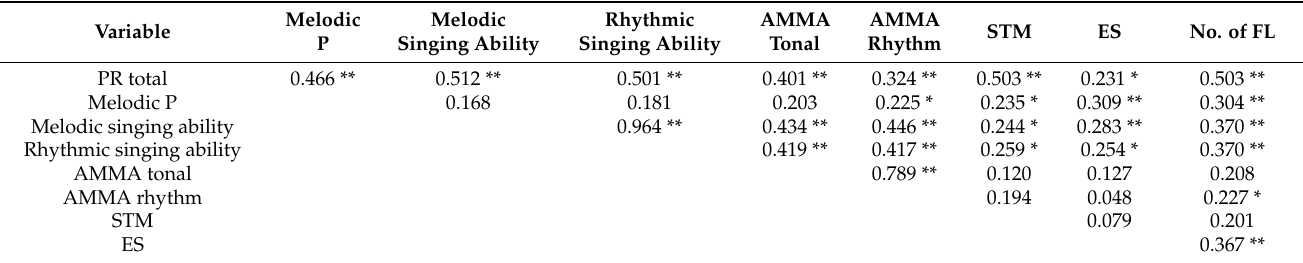
Table 3. Simple associations of the variables of this